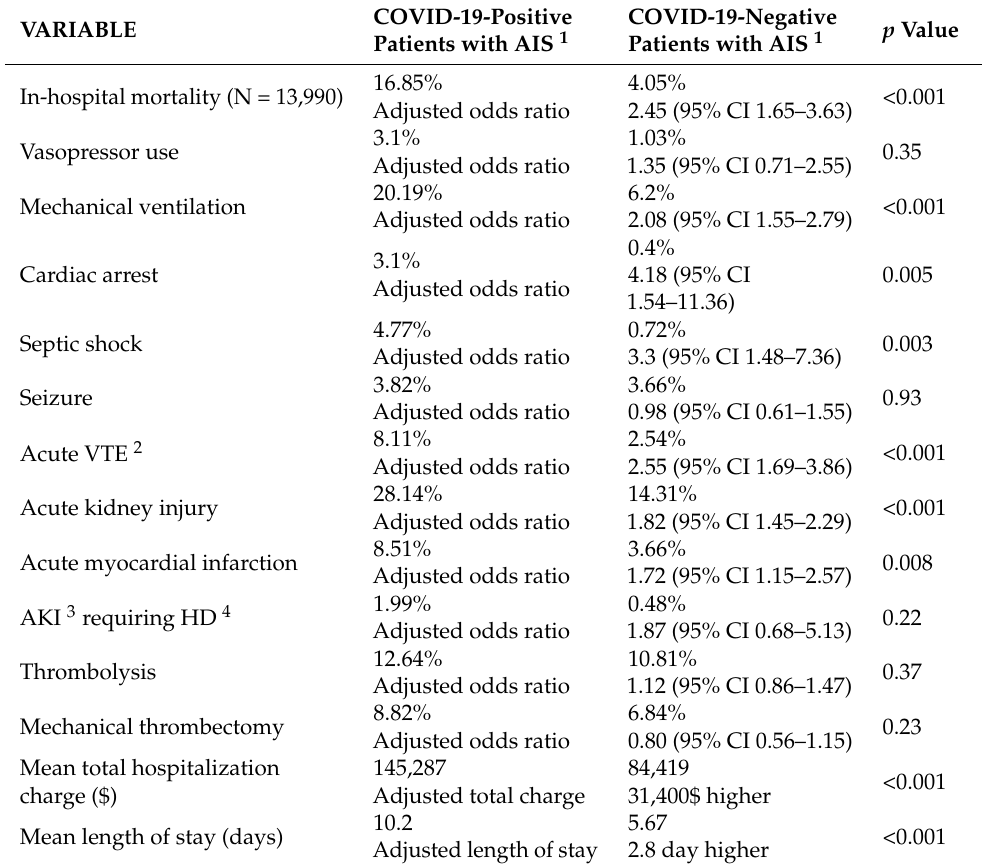
Table 4. In-hospital outcomes of propensity matched